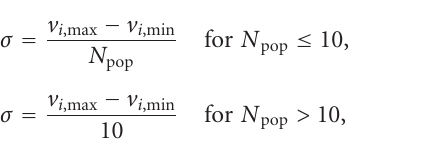
search space from being bound in the local optimum.